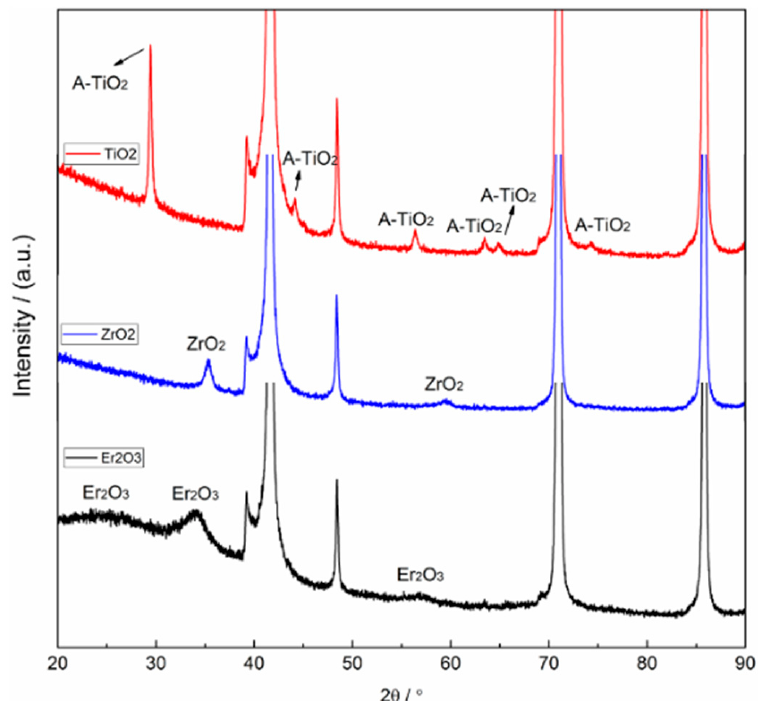
Figure 3. XRD patterns of oxides coating on CVD-SiC substrate after 1-time dipping. Black is for Er2O3 coating; Blue is for ZrO2 coating; Red is TiO2 coating.